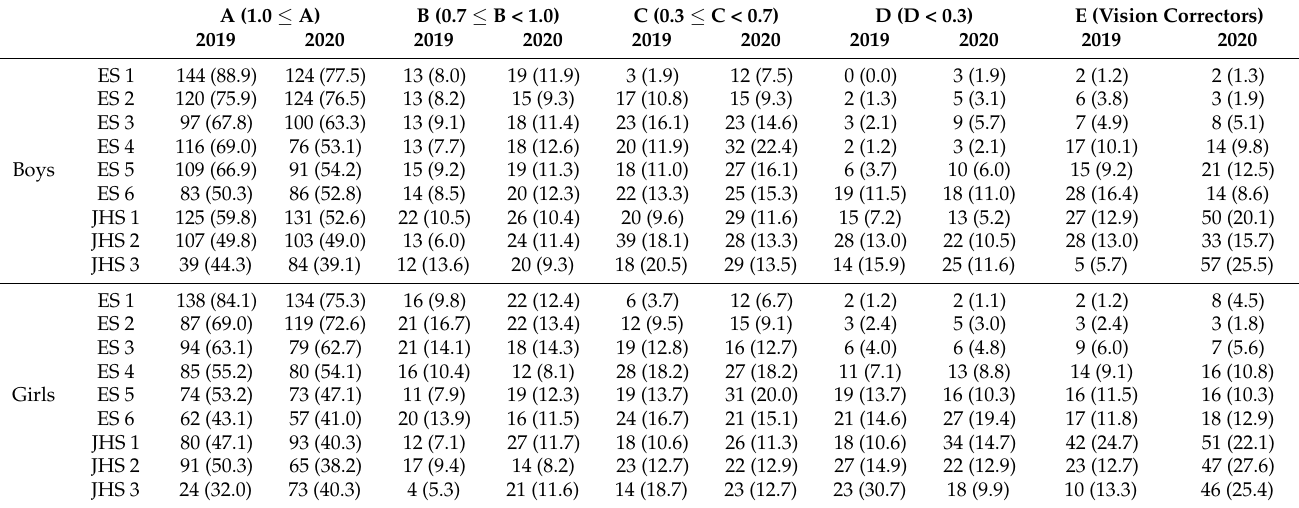
Table 2. Assessment results of the VA test according to sex and grade.